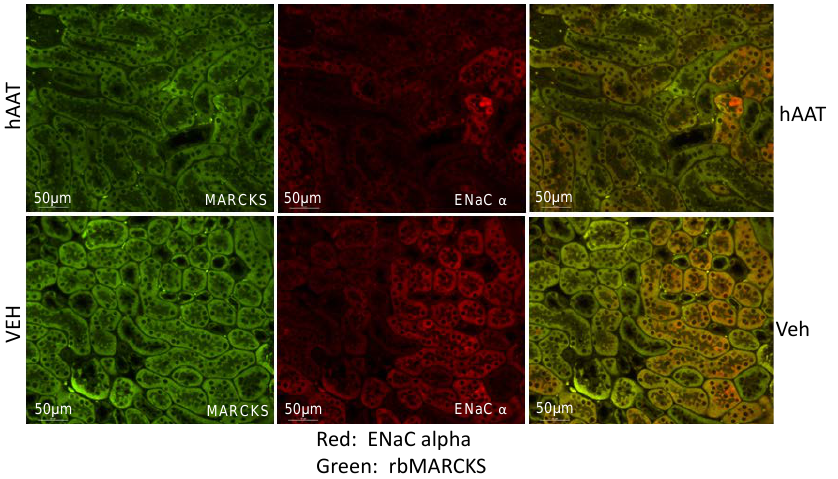
Figure 6. Colocalization of MARCKS and ENaC alpha subunit protein expression in the kidney cortex of hypertensive diabetic db/db mice after treatment with vehicle or hAAT. Representative immunohistochemistry images using a mouse monoclonal antibody against the alpha subunit of ENaC and a rabbit polyclonal antibody against recombinant MARCKS protein were used to inves- tigate colocalization of the two proteins in the hypertensive diabetic db/db kidney. N = 6 mice in each group.